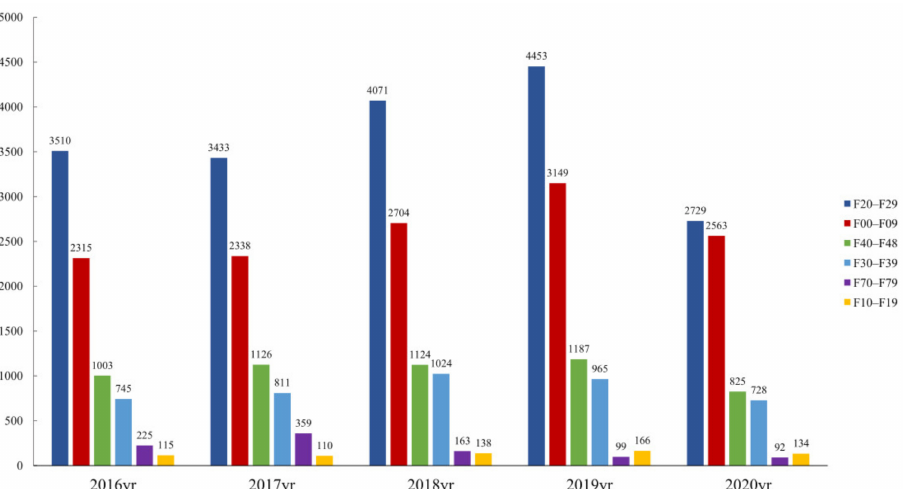
Figure 3. Utilization of the six categories of mental health services at different years. Legend: From January to July 2020 and the same period from 2016 to 2019, the utilization of the six categories of mental health services, F01–F09, F10–F19, F20–F29, F30–F39, F40–F48, and F70–F79. Note: